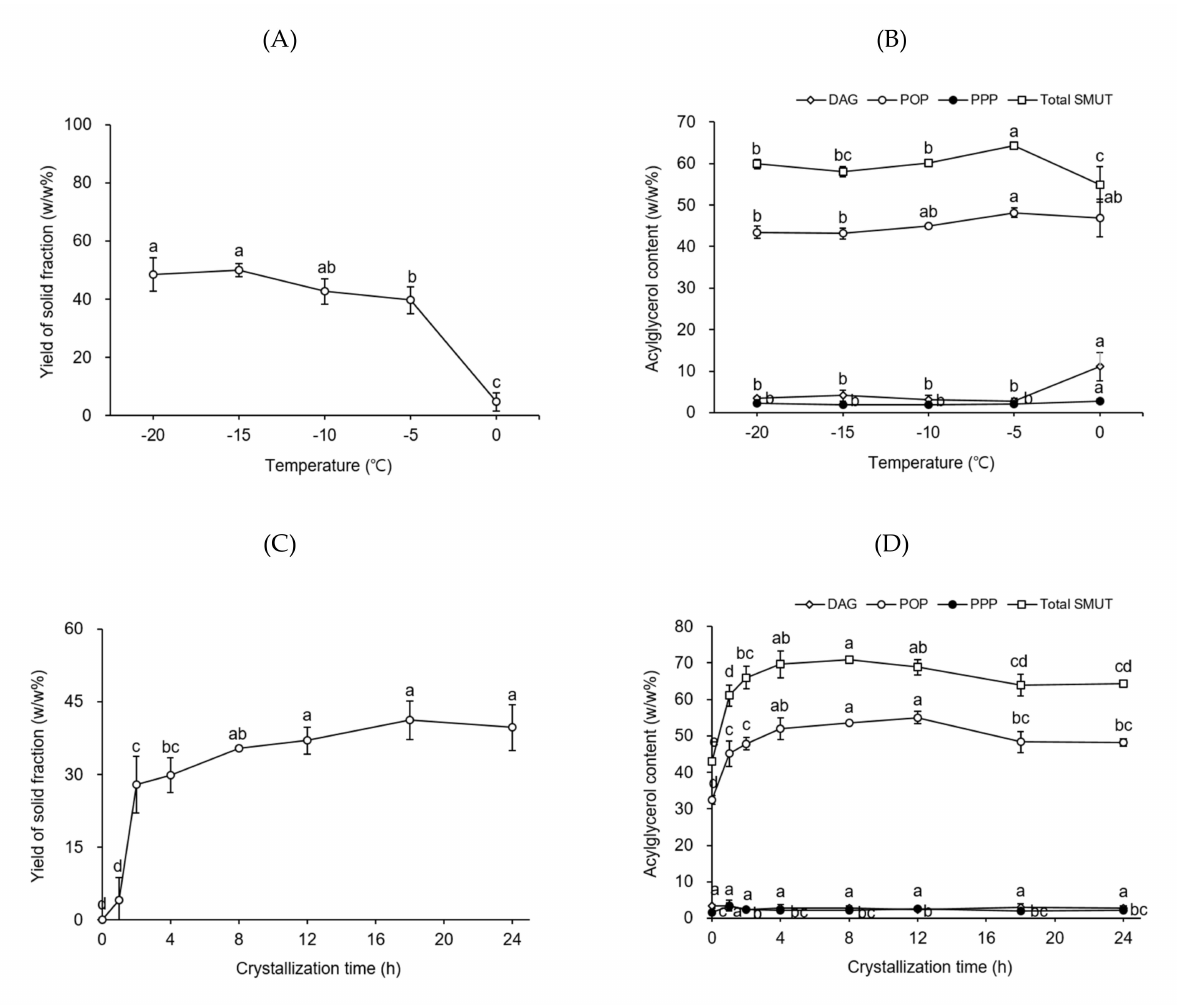
Figure 2. Yield of the solid fraction ( A , C ) and the contents of diacylglycerols (DAGs), tripalmitin (PPP), 1,3-dipalmitoyl-2- oleoyl glycerol (POP), and total symmetric monounsaturated triacylglycerols (SMUTs) in the solid fraction ( B , D ) obtained from PS-LF (a liquid fraction prepared by the first fractionation of palm stearin under the best conditions established in this study) during the second hexane fractionation step as a function of temperature and crystallization time, respectively. Fractionation was conducted by using 5 g PS-LF in a flat-bottom glass vessel (8 cm × 3.5 cm i.d.). Different letters (a–e) indicate significant differences between samples ( p <